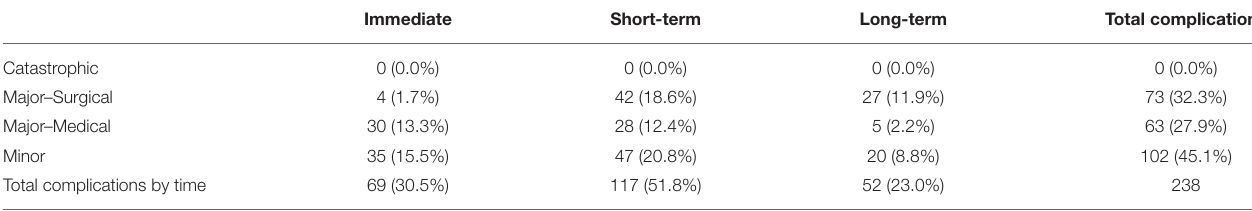
TABLE 3 | The number of most severe complication per patient ( n = 238) and percentage of total patients ( n = 226) categorized by severity and timing. Immediate